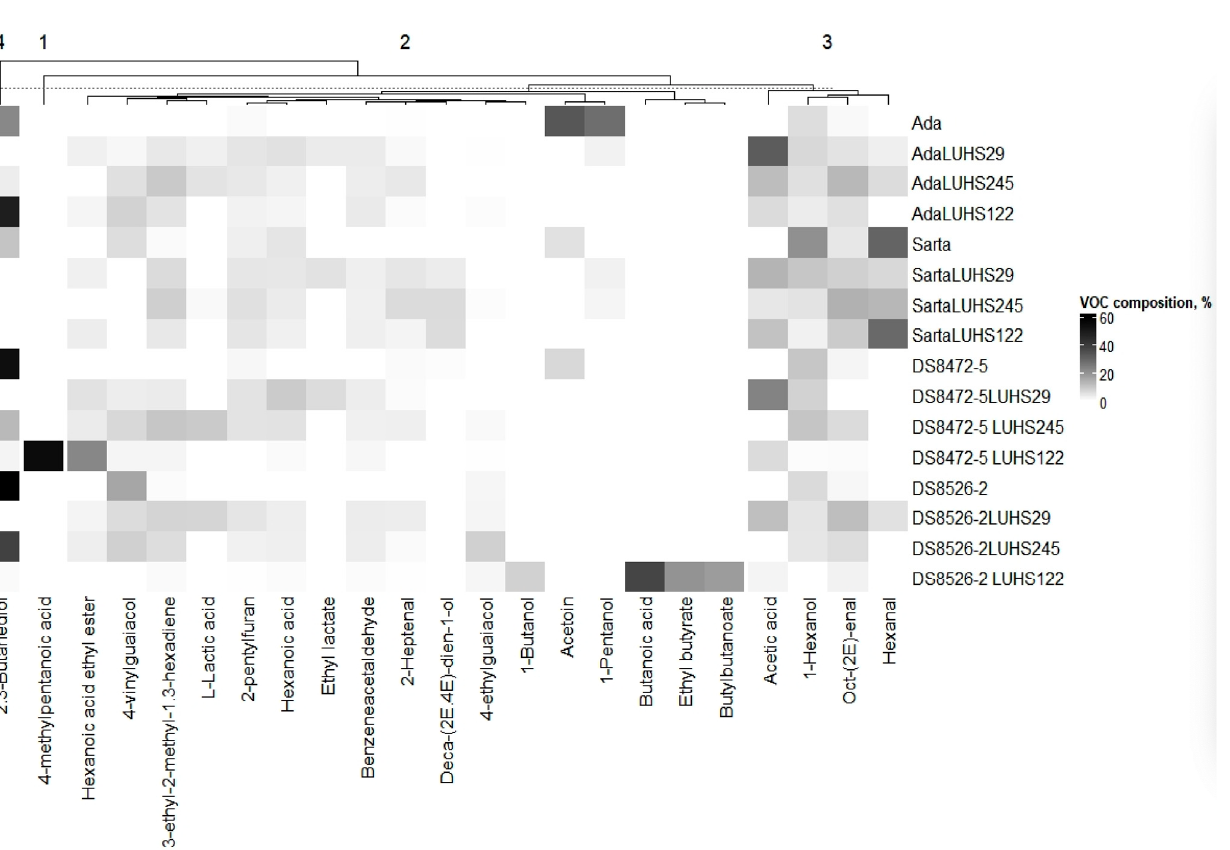
Figure 3. Volatile compounds that are >5% in at least one wheat wholemeal sample (LUHS29— fermented with Pediococcus acidilactici LUHS29 strain; LUHS245—fermented with Liquorilactobacillus uvarum LUHS245 strain; LUHS122—fermented with Lactiplantibacillus plantarum LUHS122 strain. Data are represented as means ( n = 3)).